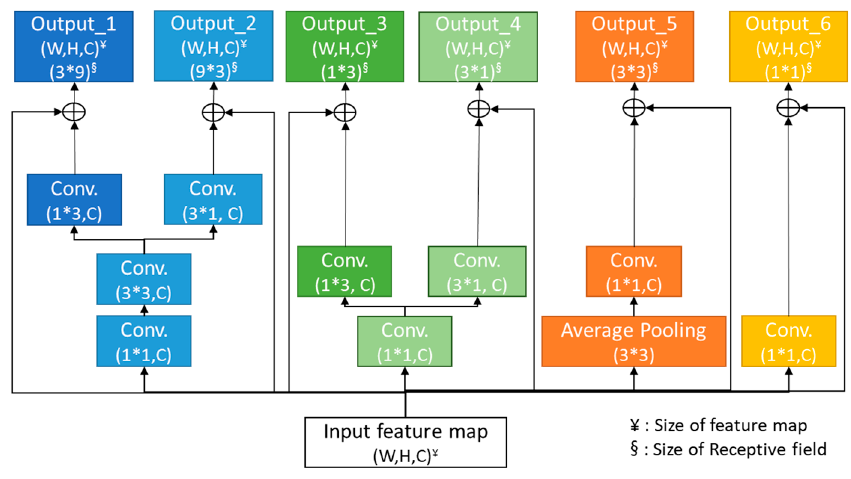
Figure 3. Network architecture of the scale pyramid.